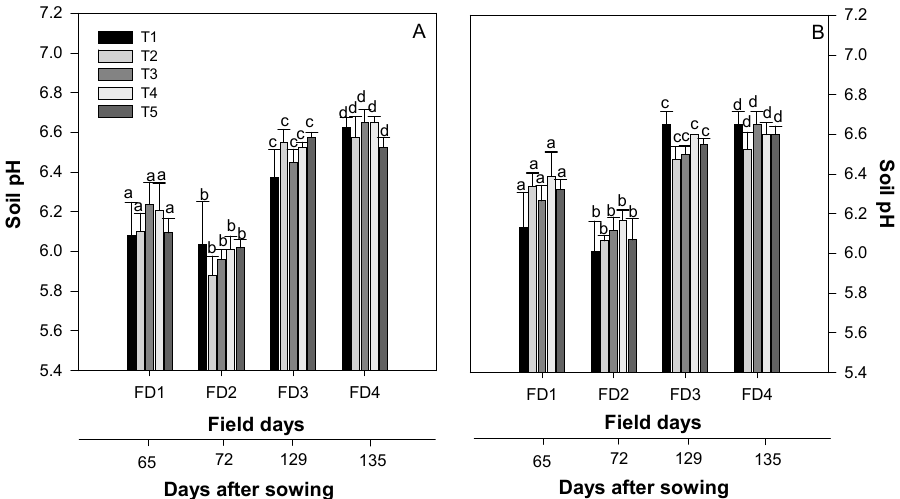
Figure 4. E ff ects of di ff erent soil amendments on temporal variations of soil pH at 0–10 cm ( A ) and 10–20 cm ( B ) sowing depth in podzolic soils under various nutrient management practices. Each vertical bar represents mean whereas bar errors show ± standard error for three replications. Lettering is independent of each